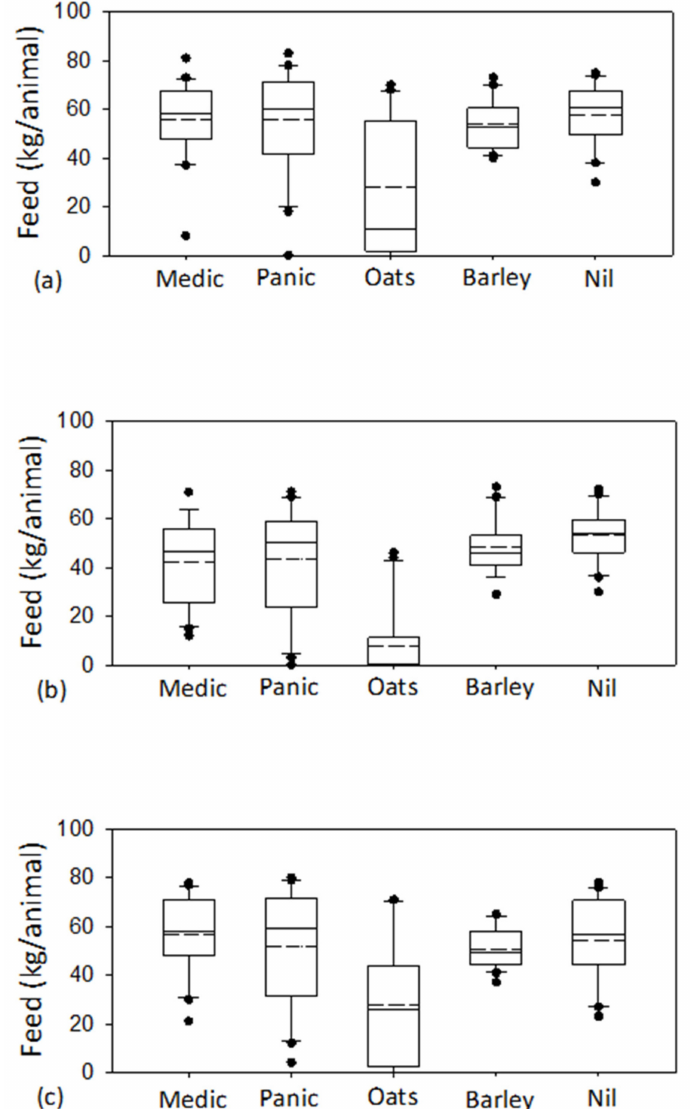
Figure 8. Long-term annual supplementary feed requirements at ( a ) Waitchie, ( b ) Kellerberrin and ( c ) Waikerie. Boxes indicate the 25 and 75th percentiles, whiskers (error bars) indicate the 90th and 10th percentiles, line within the box the median, segmented line the mean. Nil indicates system with no interrow plants, only